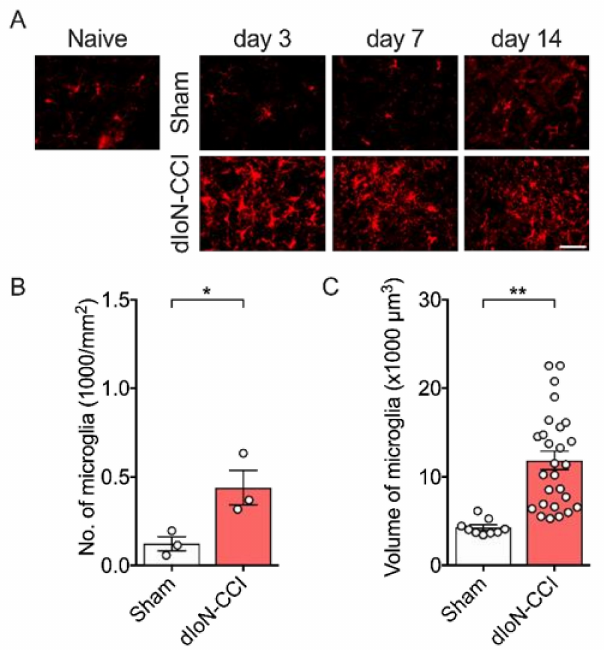
Figure 4. Activation of Sp5c microglia following sham and dIoN-CCI. ( A ) Fluorescent photomicro- graphs of Iba1, a microglial marker, Sp5C from naïve, sham-operated and dIoN-CCI mice 3, 7, 14 days following surgery. One section was taken from one mouse on Day 3 and Day 7. One slide was taken from seven mice on Day 14. Scale bar = 50 µ m. ( B ) Mean density (number of cells/mm 2 ) of n = 3 mice and ( C ) individual cell volumes ( n = 9 (sham) or 27 (dIoN-CCI) cells from 3 consecutive ipsilateral sections) in Sp5C 14 days following surgery. Data are expressed as individual and mean ± SEM.